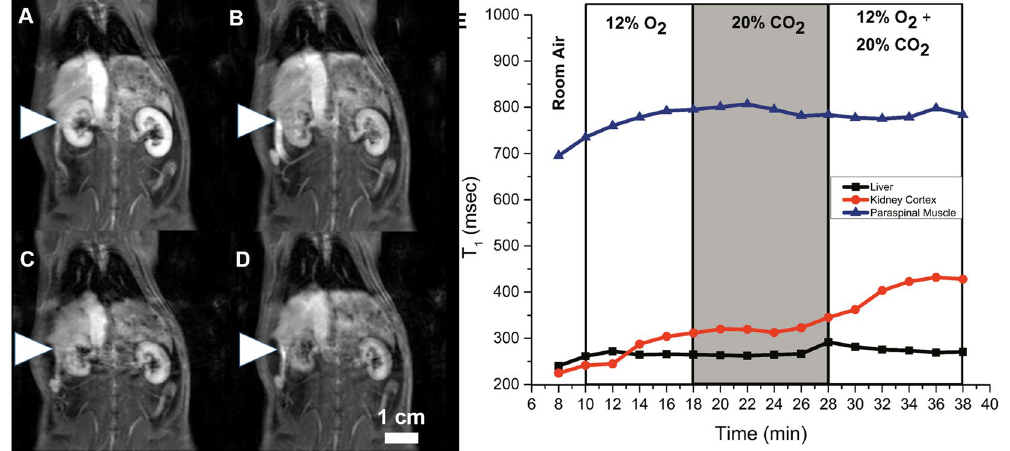
Figure 3. Dynamic MR imaging of differential microvascular response to hypercapnia and hypoxia. The kidney is shown on T 1 -weighted images acquired at the end of successive 8–12 minute gas challenges in a rat subjected to the following sequence: normoxia ( A ) → hypoxia (12% O 2 ) ( B ) → hypercapnia (20% CO 2 ) ( C ) → hypoxic hypercapnia (12% O 2 + 20% CO 2 ) ( D ). Corresponding temporal evolution of changes in T 1 relaxation times in the liver, kidney, and paraspinal muscle ( E